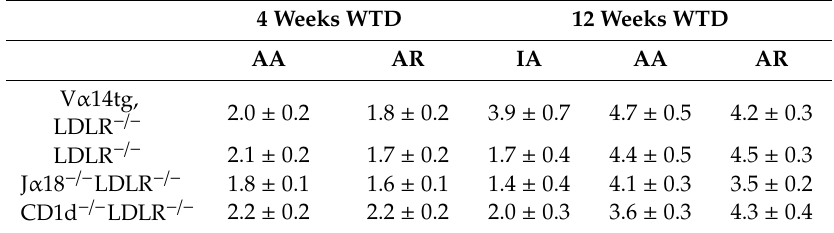
Table3. Histologicallesion scores (seeTableS1) forfemalemice. IA = innominateartery, AA = ascending aorta, AR = aortic root. For 12 weeks of WTD, n = 11 or 12. For 4 weeks or WTD, n = 10 or 11. 4 Weeks WTD 12 Weeks